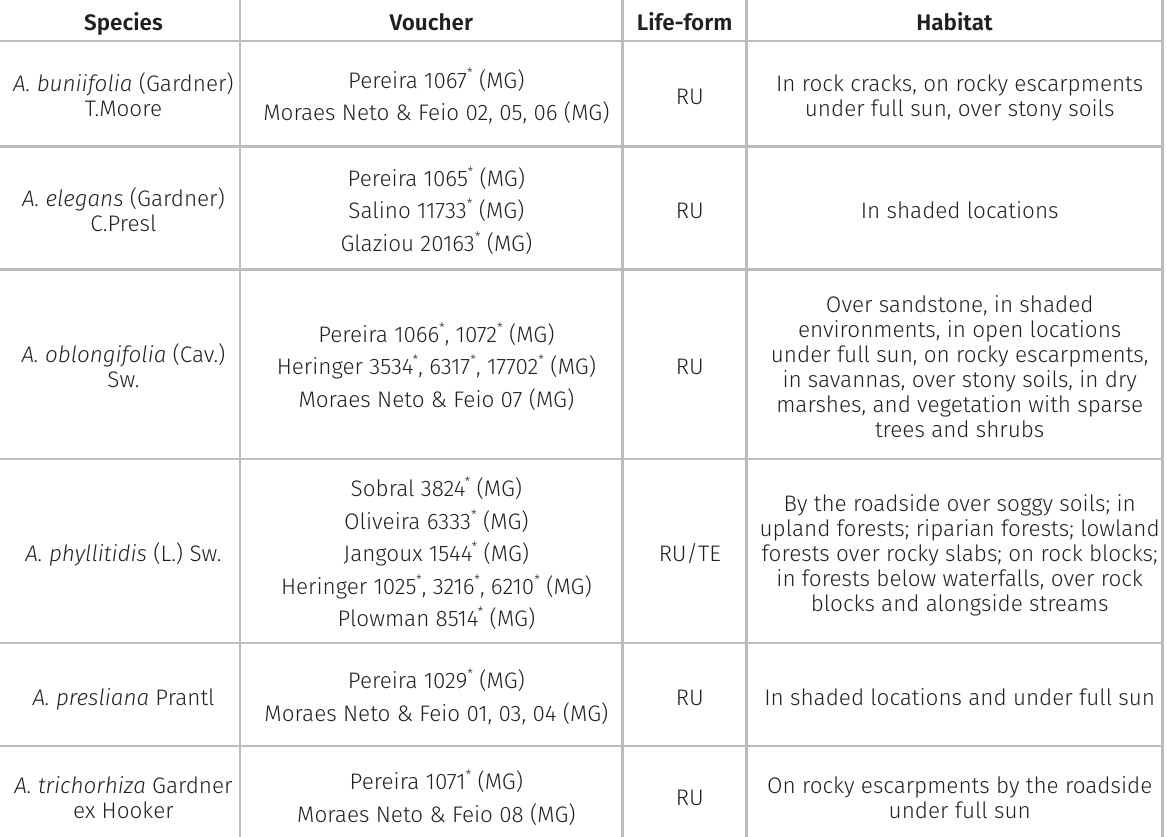
Table I. Selected taxa and the respective analyzed vouchers. Herbarium acronyms in parentheses, following Thiers (2018). Notes: (TE) terrestrial; (RU) rupicolous. Material collected from herbarium specimens is indicated with an (*).